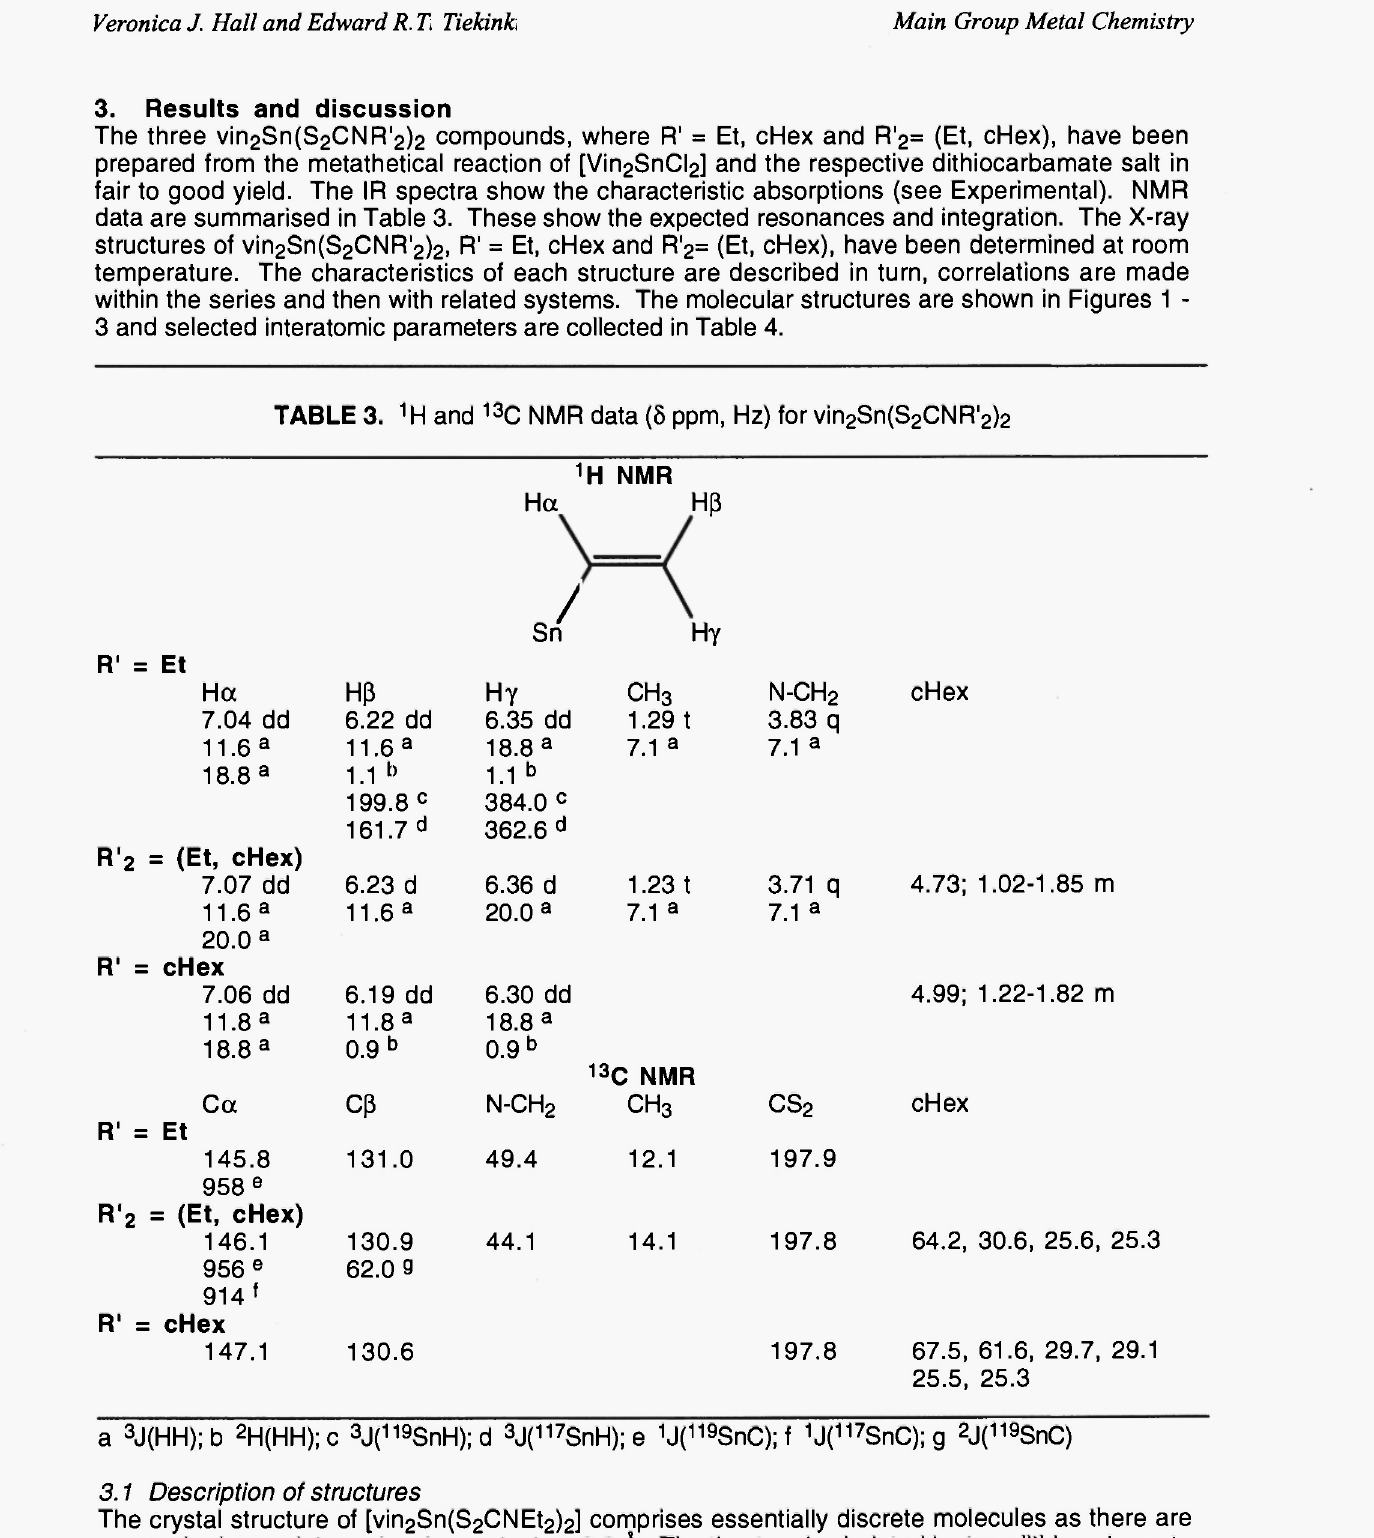
TABLE 3. 1 H and 13 C NMR data (δ ppm, Hz) for vin2Sn (S 2 CNR' 2 )